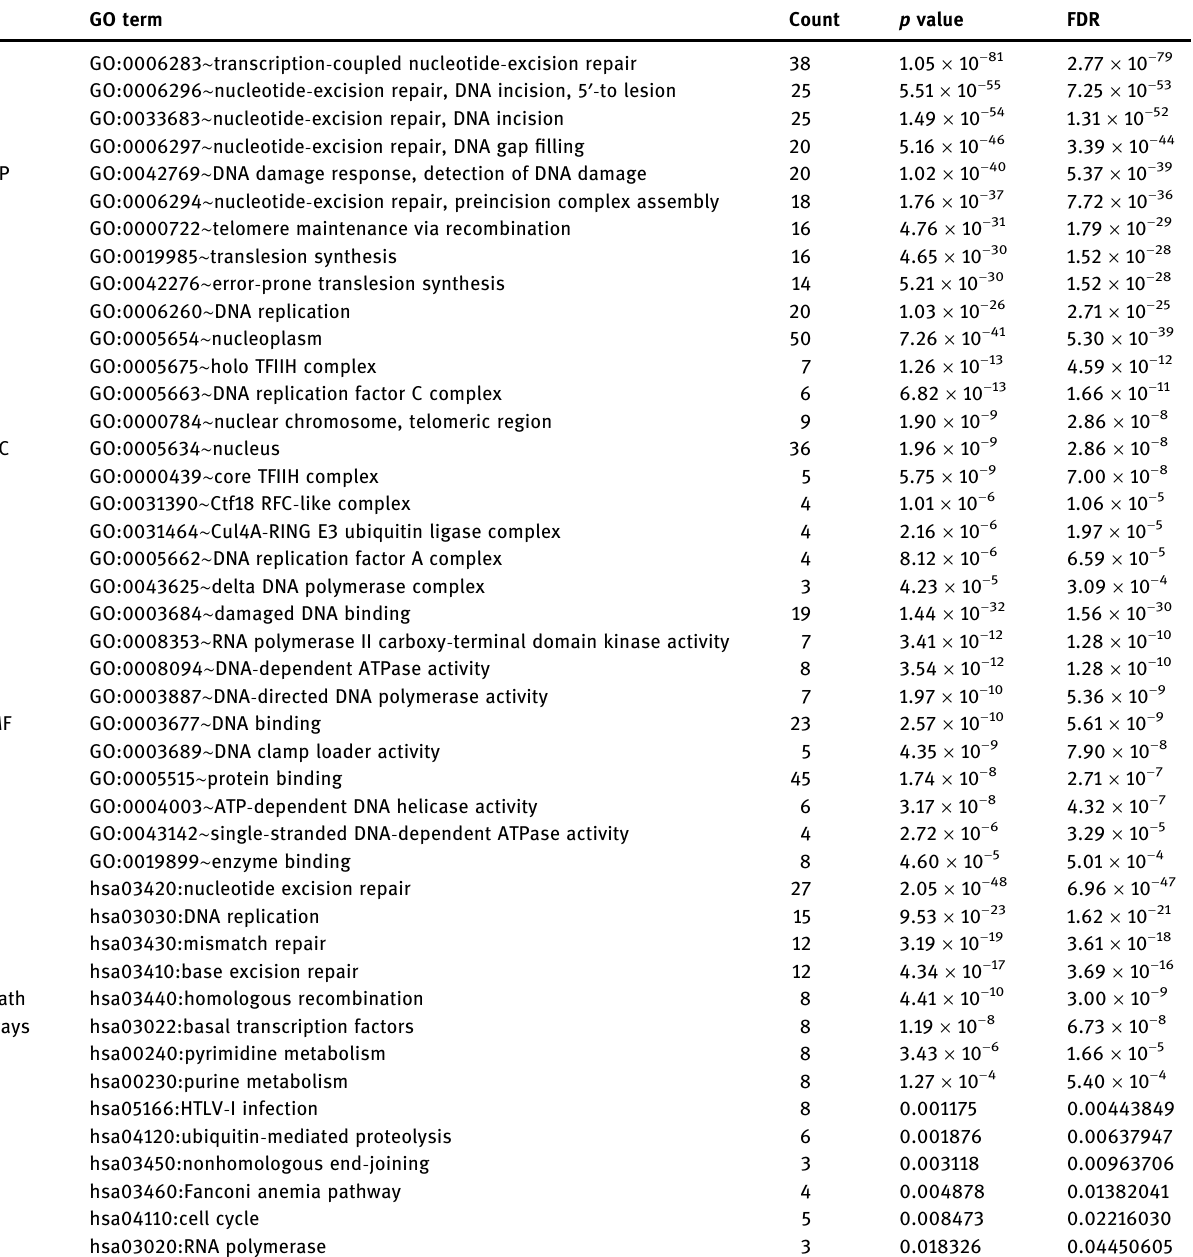
Table 2: Functional annotation enrichment analysis of LIG3 and their interaction genes performed with the DAVID database GO term Count